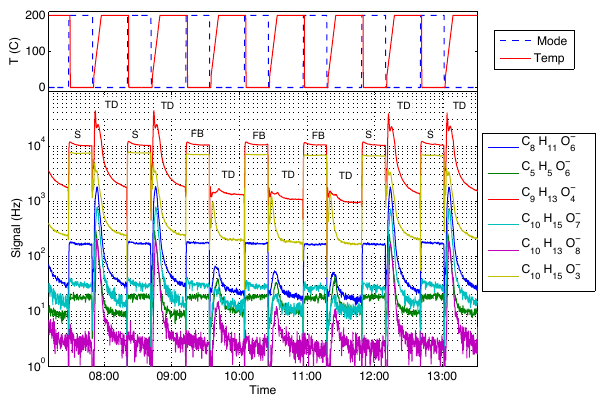
Fig. 3. The FIGAERO sampling from a steady-state chamber dur- ing performance evaluation. Top: FIGAERO manifold operational mode (blue dashed line), high during gas phase sampling and par- ticle collection, low during thermal desorption, and UHP N 2 tem- perature (red solid line) during thermal desorption of the collected particle samples. The temperature was ramped at 20 ◦ Cmin − 1 from room temperature to 200 ◦ C where it was held for ∼ 20 additional minutes (“soak”) to ensure all detectable organic material was re- moved from the filter. Bottom: time series of selected ion signals which span a large range in signals and m/Q, and which have dif- ferent filter blank behaviors are shown during the various opera- tional modes of the FIGAERO. Modes are denoted by text: (S) gas analysis and particle collection, (TD) thermal desorption, (FB) filter blank sampling (see text for details). The signals during TD that im- mediately follow the FB sampling periods represent the magnitude of the FB for a given ion